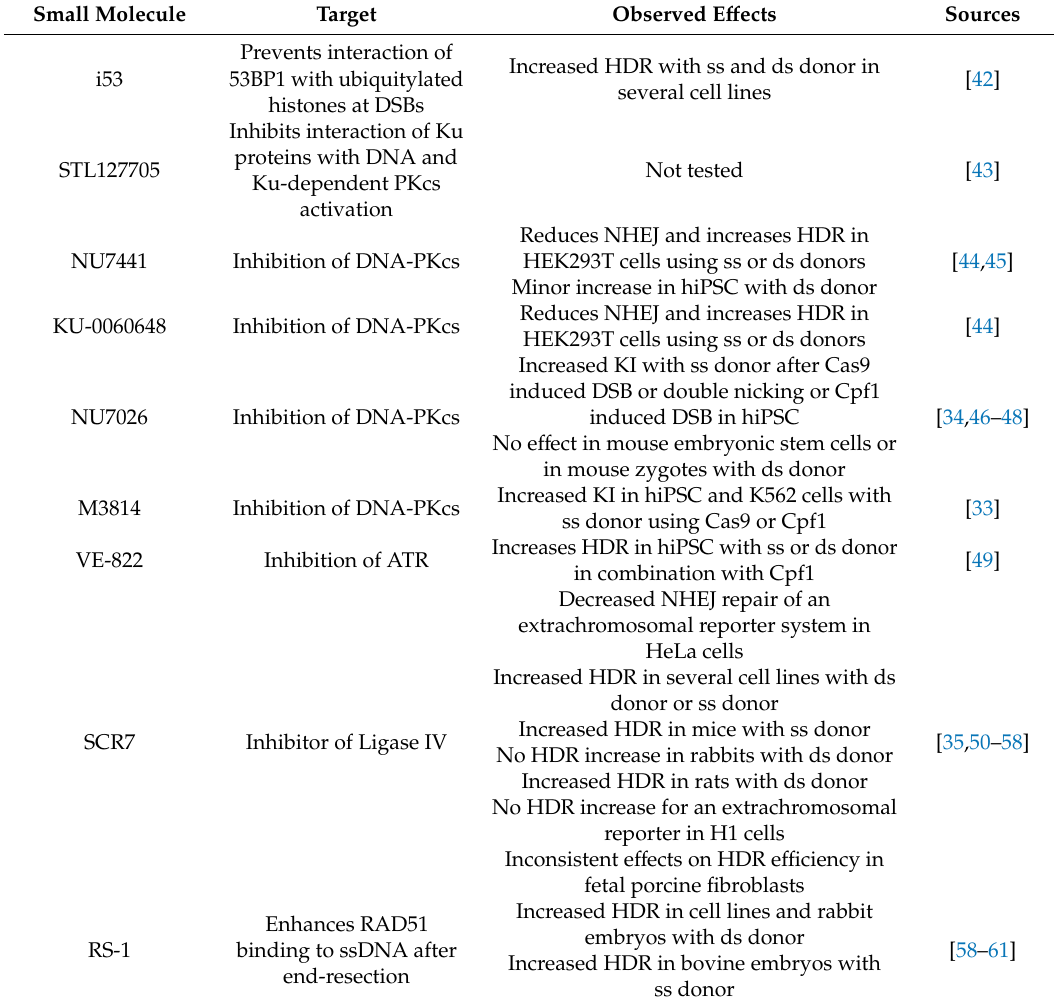
Table 1. Summary of small molecules described during this review with suggested targets and observed e ff